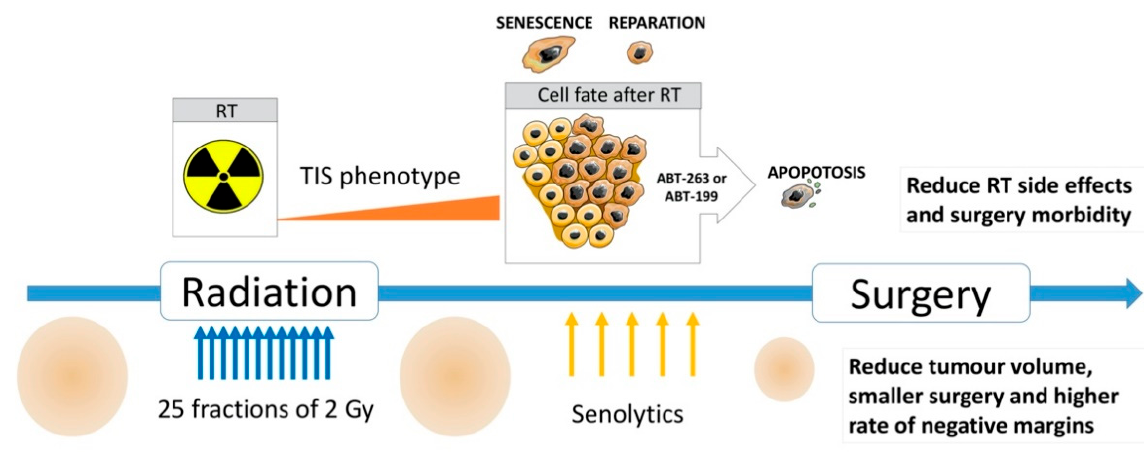
Figure 6. Potential clinical strategy for curative STS. Model in three steps proposed for management of treatment timeline of patient. For sarcomas patient, pre-operative radiation is given in several fractions and is followed by an interval of six to ten weeks before surgery. During this period of time, we hypothesize that the tumour will undergo radiation-induced senescence and this state will sensitize the cells for the use of senolytic drugs. This addition to conventional treatment may enhance tumour shrinkage and thus, potentially have positive effects on the success of the surgery as well as on reducing side effects cause by radiation over time.